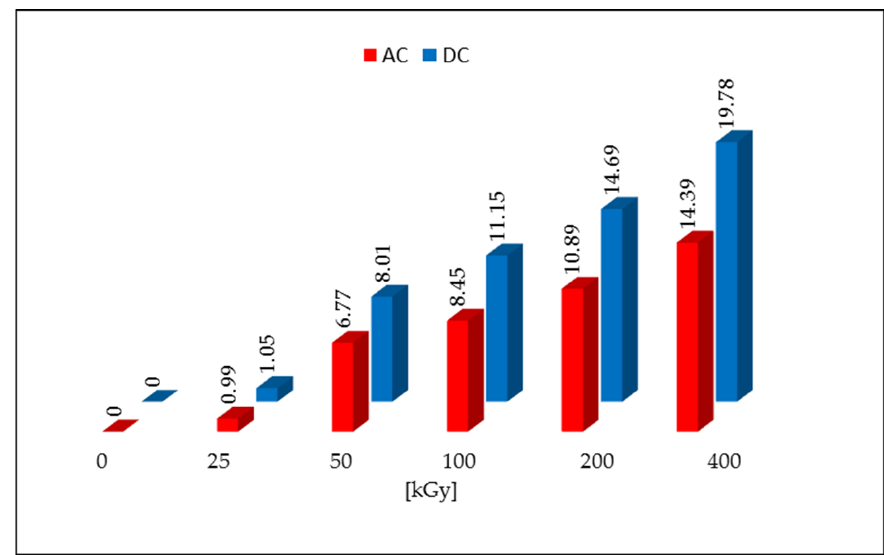
Figure 2. Color changes after irradiation with an electron beam.